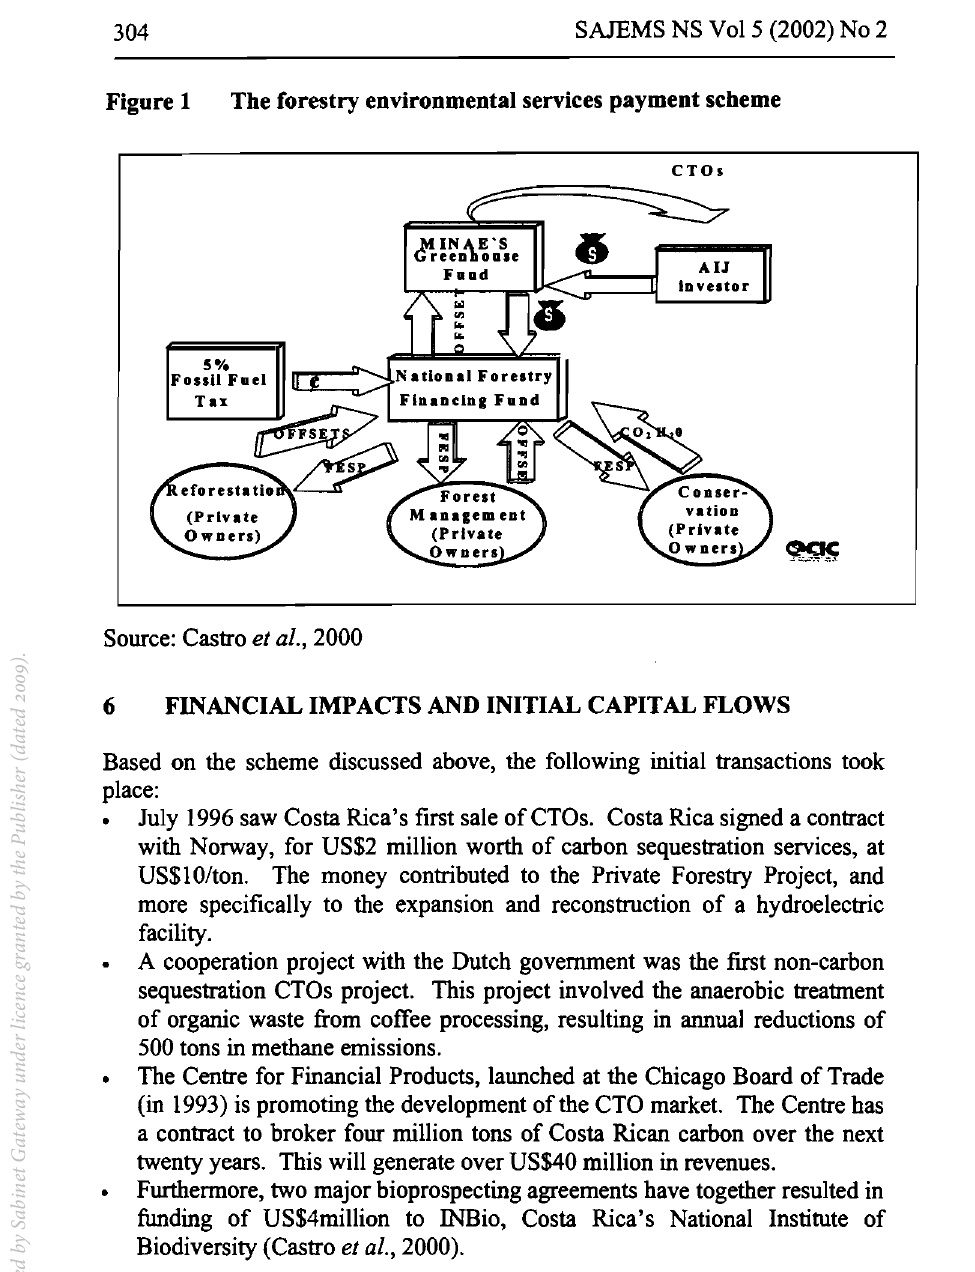
The forestry environmental services payment scheme